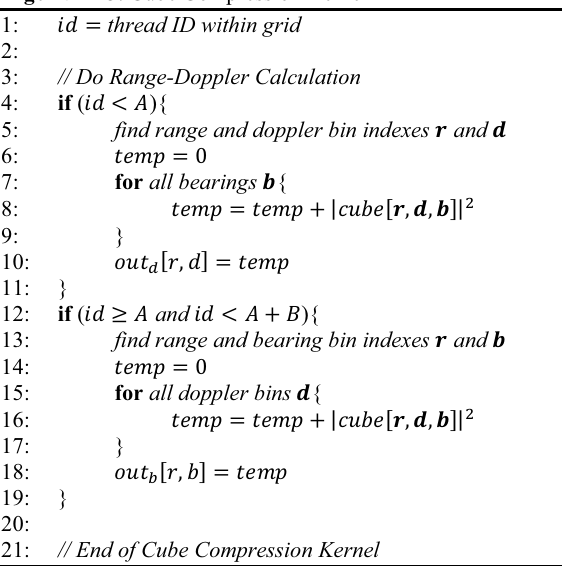
Algorithm 3. Cube Compression